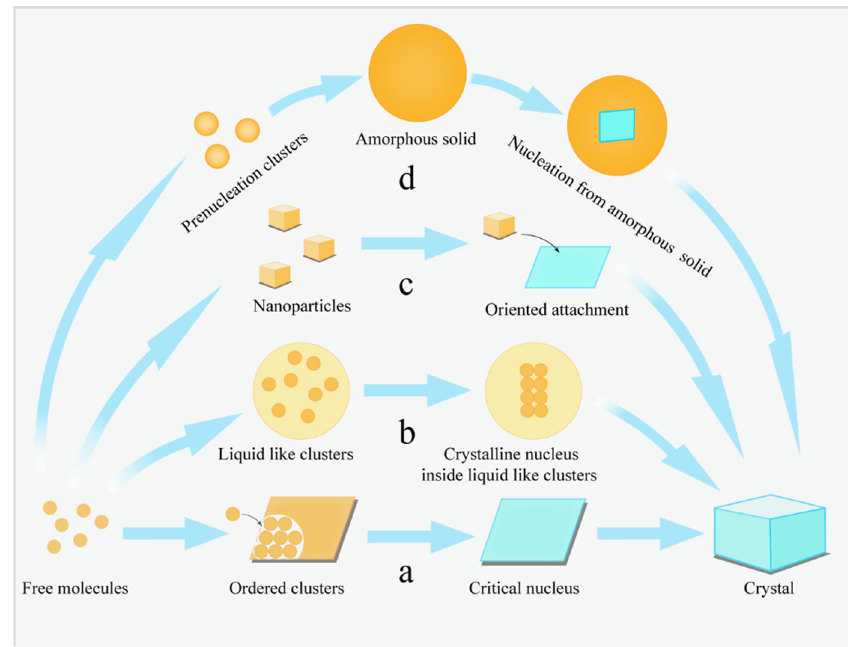
Figure 1. Schematic diagram of ( a ) classical nucleation theory, ( b ) two-step nucleation theory, ( c ). particle agglomeration theory, ( d ) prenucleation clusters theory.